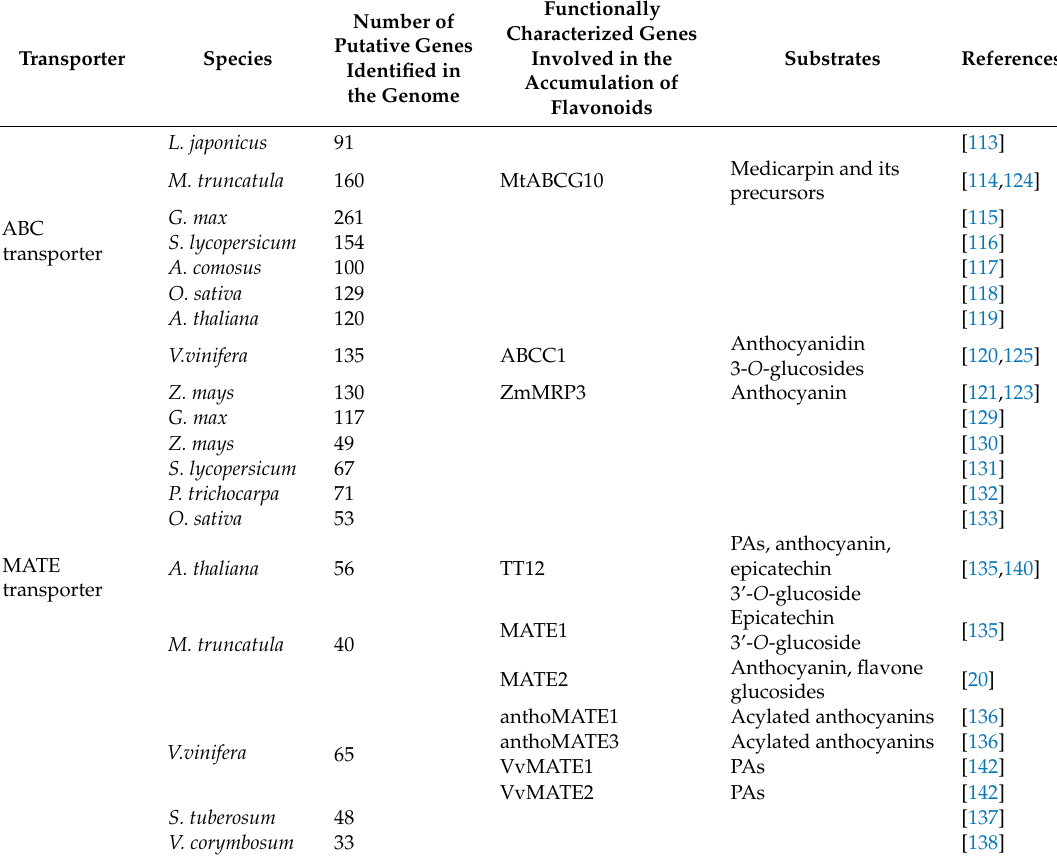
Table 2. Summary of ABC transporters and MATE transporters identified in different plant species.